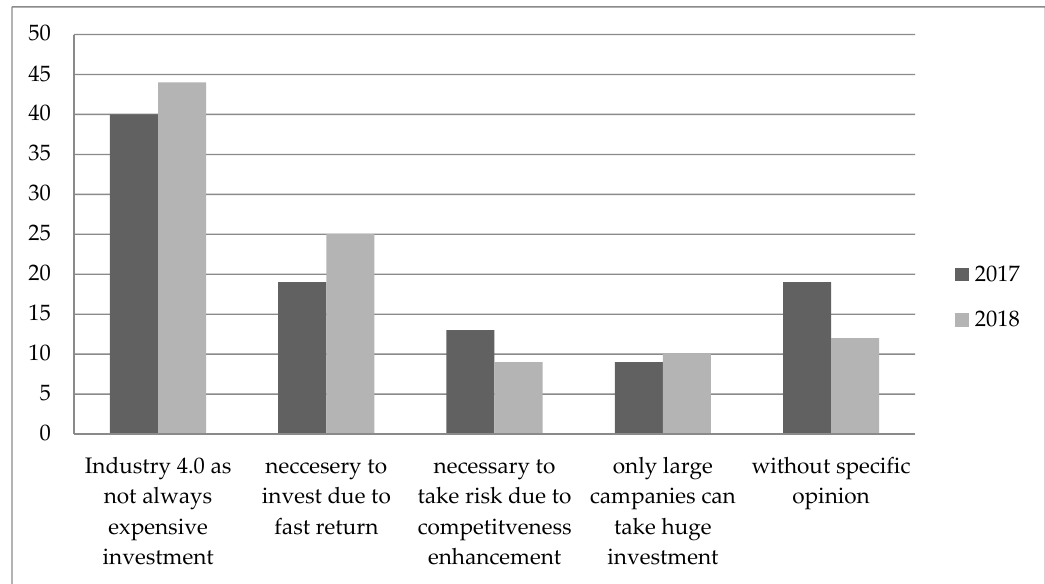
Figure 5. Your point of view on Industry 4.0 as investment demand in %. Source: own processing based on survey results.